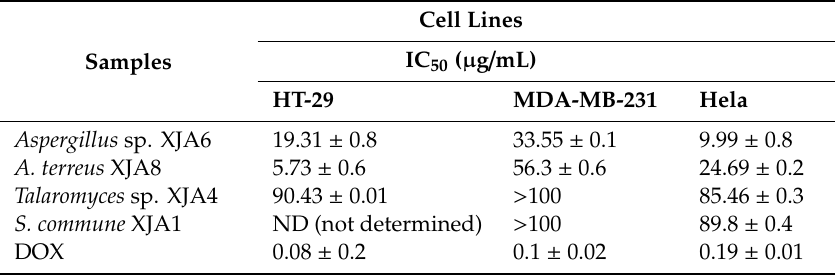
Table 5. Cytotoxic activity of ethyl acetate extracts obtained from fungal endophytes on human cancer cell lines HT-29, MDA-MB-231 and